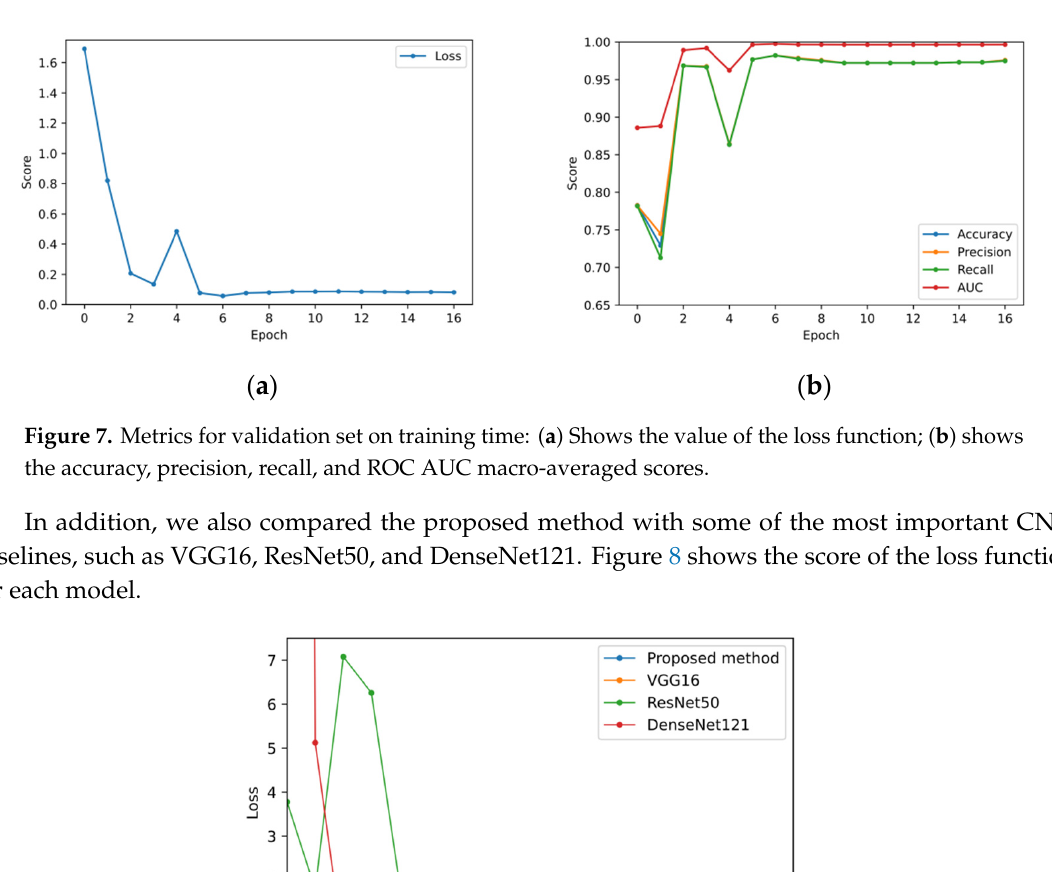
Figure 8. Metrics for validation set on training time for all CNN models.